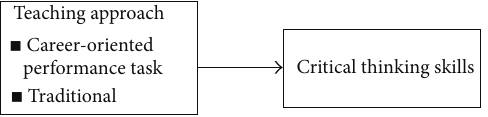
Figure 1: Conceptual framework of the study.